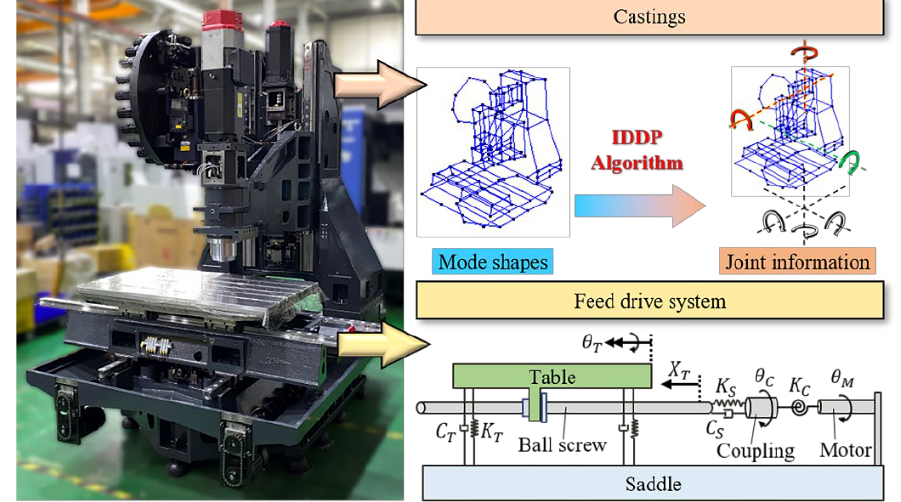
Figure 2. Structural classification.